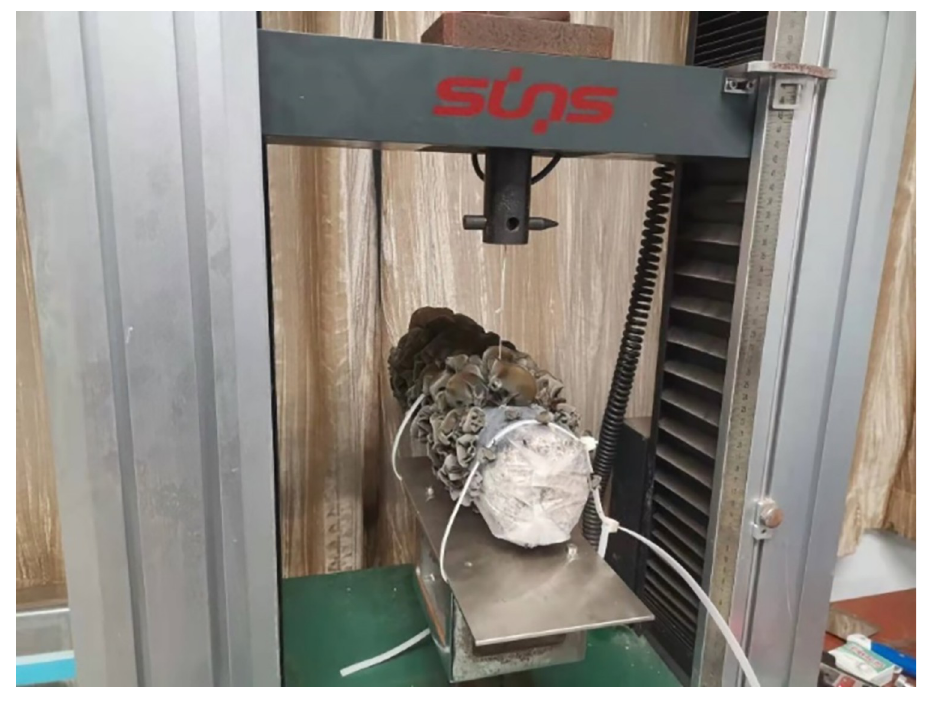
Fig 4. The test of separation